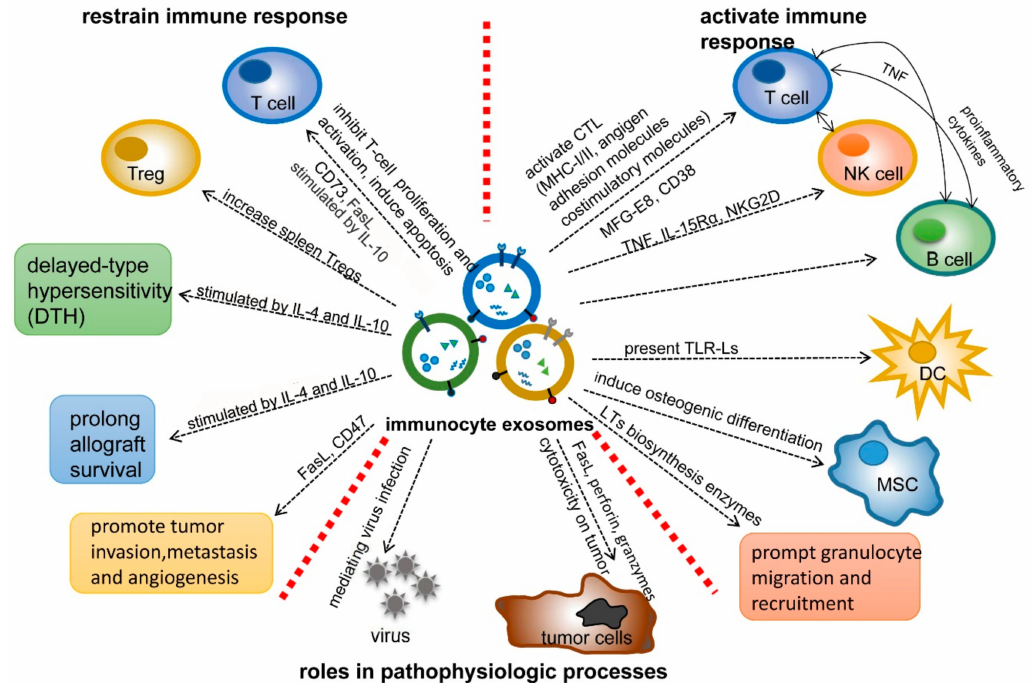
Figure 3. E ff ects of immunocyte-derived exosomes in the immune response and the pathogenesis of disease. Shown is the spectrum of immunocyte exosome functions that have been identified to date. Immunocyte exosomes stimulate immune responses by potentiating antigen presentation by dendritic cells (DCs) and B cells, driving CD4 + T cell-mediated help, activating cytotoxic e ff ector function of NK and CD8 + T cells, or by directly mediating cytolytic activity. On the other